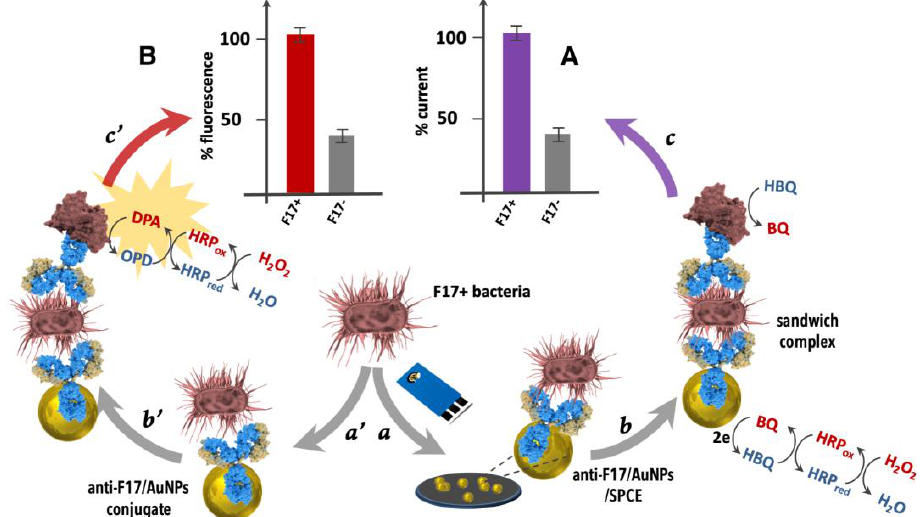
Figure 3. Principle of the ( A ) Electrochemical and ( B ) Fluorescence bioassays for E. coli F17A fimbrial protein detection. Steps: (a): adding F17 − positive E. coli to anti− F17/AuNPs/SPCE; (b): adding anti− F17 − HRP conjugate and (c): adding H 2 O 2 /HBQ and electrochemical readout at −0 .1 V and ( a’ ): adding F17-positive E. coli to anti− F17/AuNPs conjugate; ( b’ ): adding anti− F17-HRP conjugate and ( c’ ): adding H 2 O 2 /OPD and fluorescence readout at 550 nm.